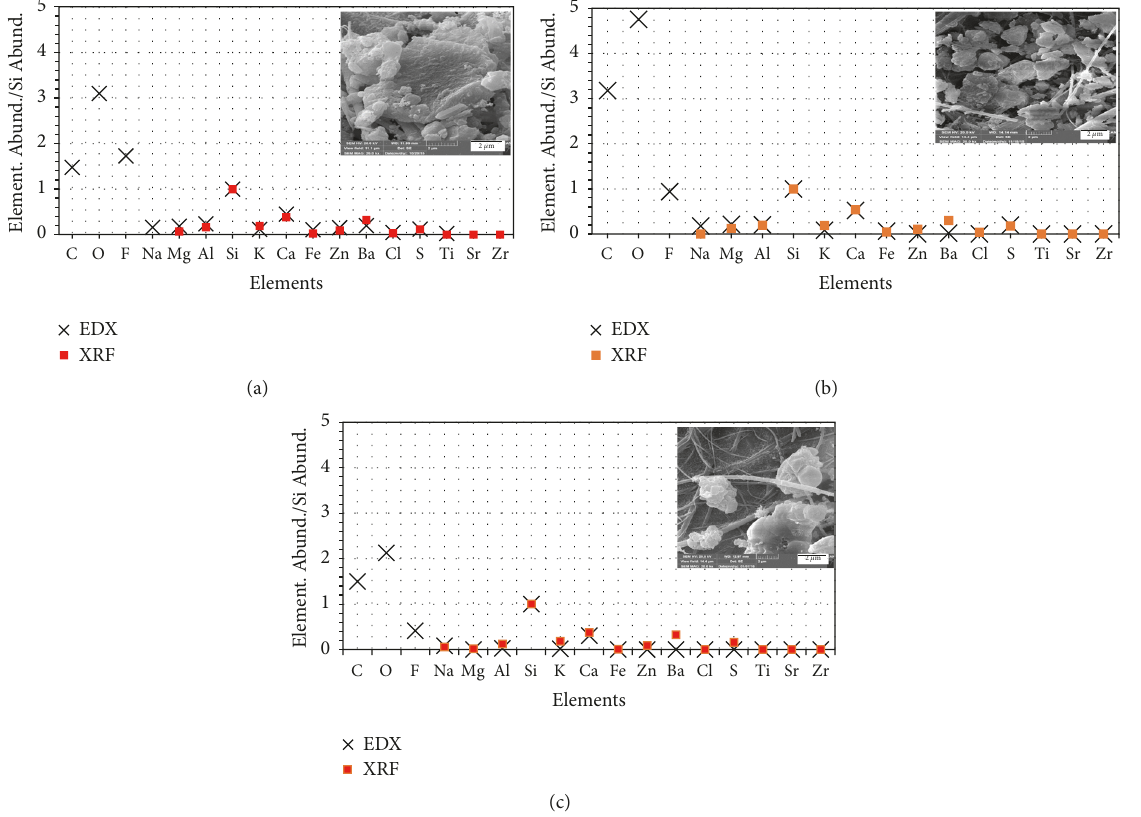
Figure 5: Distribution of elemental structure of particulate matter collected from (a) Dhahran, (b) Khobar, and (c) Dammam using XRF